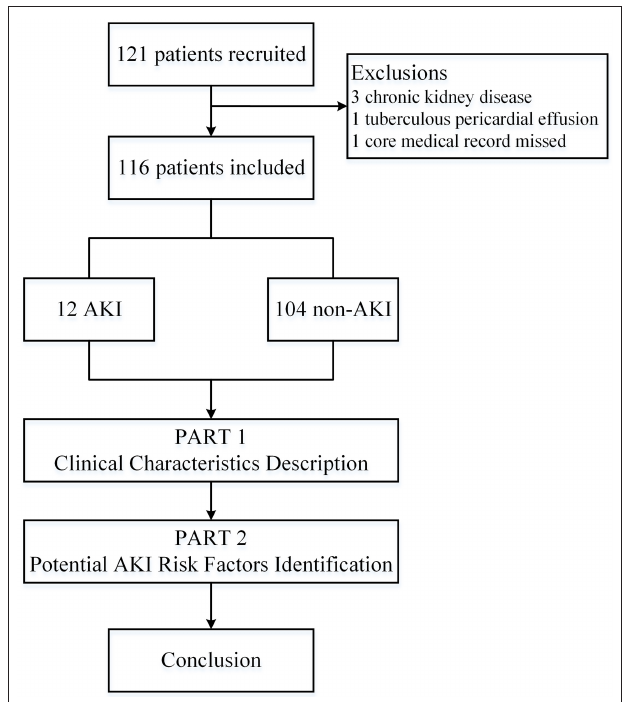
FIGURE 1 | Flowchart of the study. AKI, acute kidney injury.